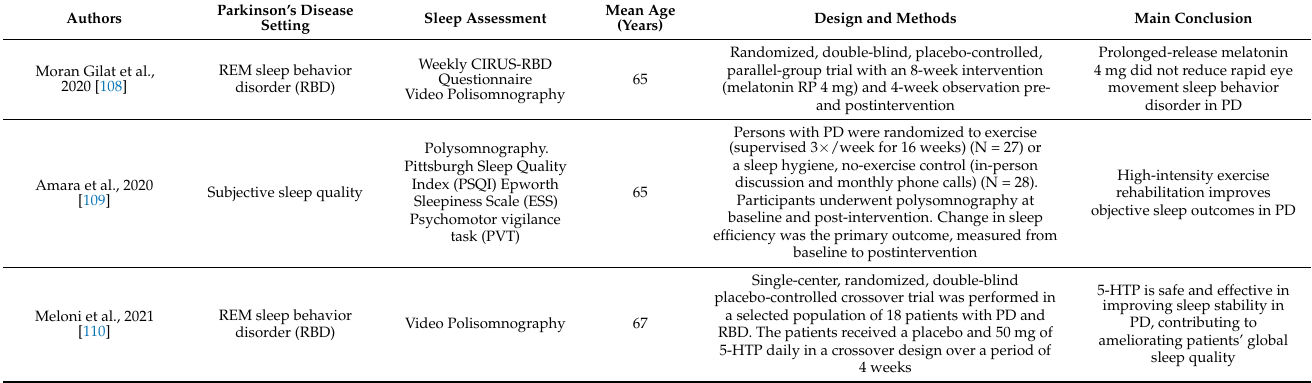
Figure 1. PRISMA diagram of selection process. Table 1. Summary of the evidence currently available in the